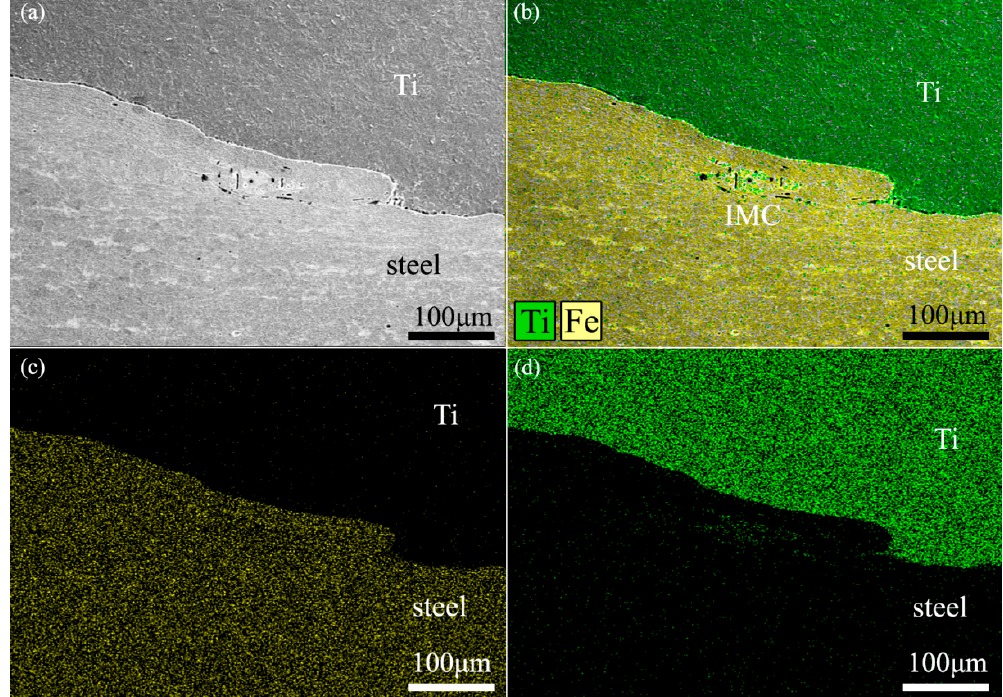
Figure 5. ( a ) Bonding interface in TA1 / LAS composite plate and ( b ) EDX analysis maps showing the distribution of Fe and Ti. EDX-derived elemental maps for ( c ) Fe and ( d ) Ti. Elemental line scans of Fe and Ti using EDS were conducted to determine the distribution of elements across the bonding interface. Typical interface microstructure and compositional profiles of